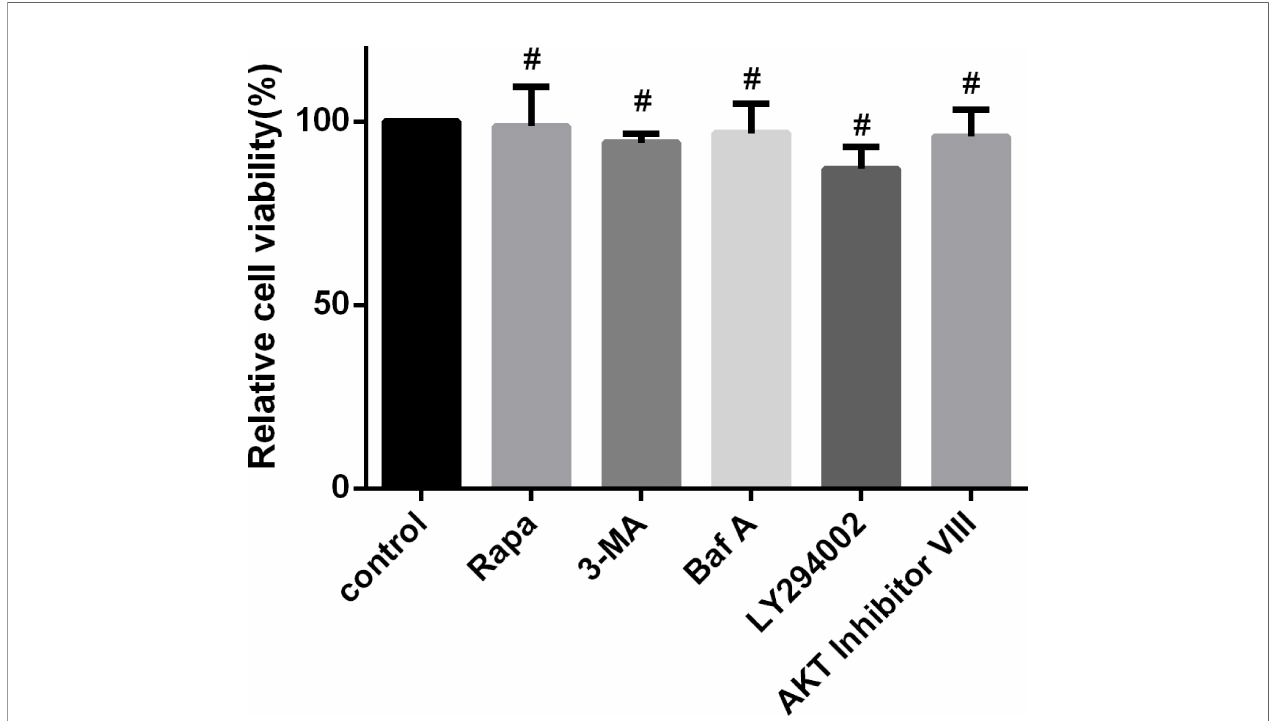
FIGURE 6 | Regulation of autophagy and upstream signaling pathways does not affect cell viability. PMs were treated separately with rapamycin (1 m M), 3-MA (2.5 mM) for 24 h, Baf A (100 nM) for 4 h, LY294002 (25 m M), and AKT inhibitor VIII (1.25 m M) for 1 h. Cell viability was measured using a Cell Counting Kit-8 (CCK- 8) assay. Data are shown as the mean ± SEM for three independent experiments. # P >